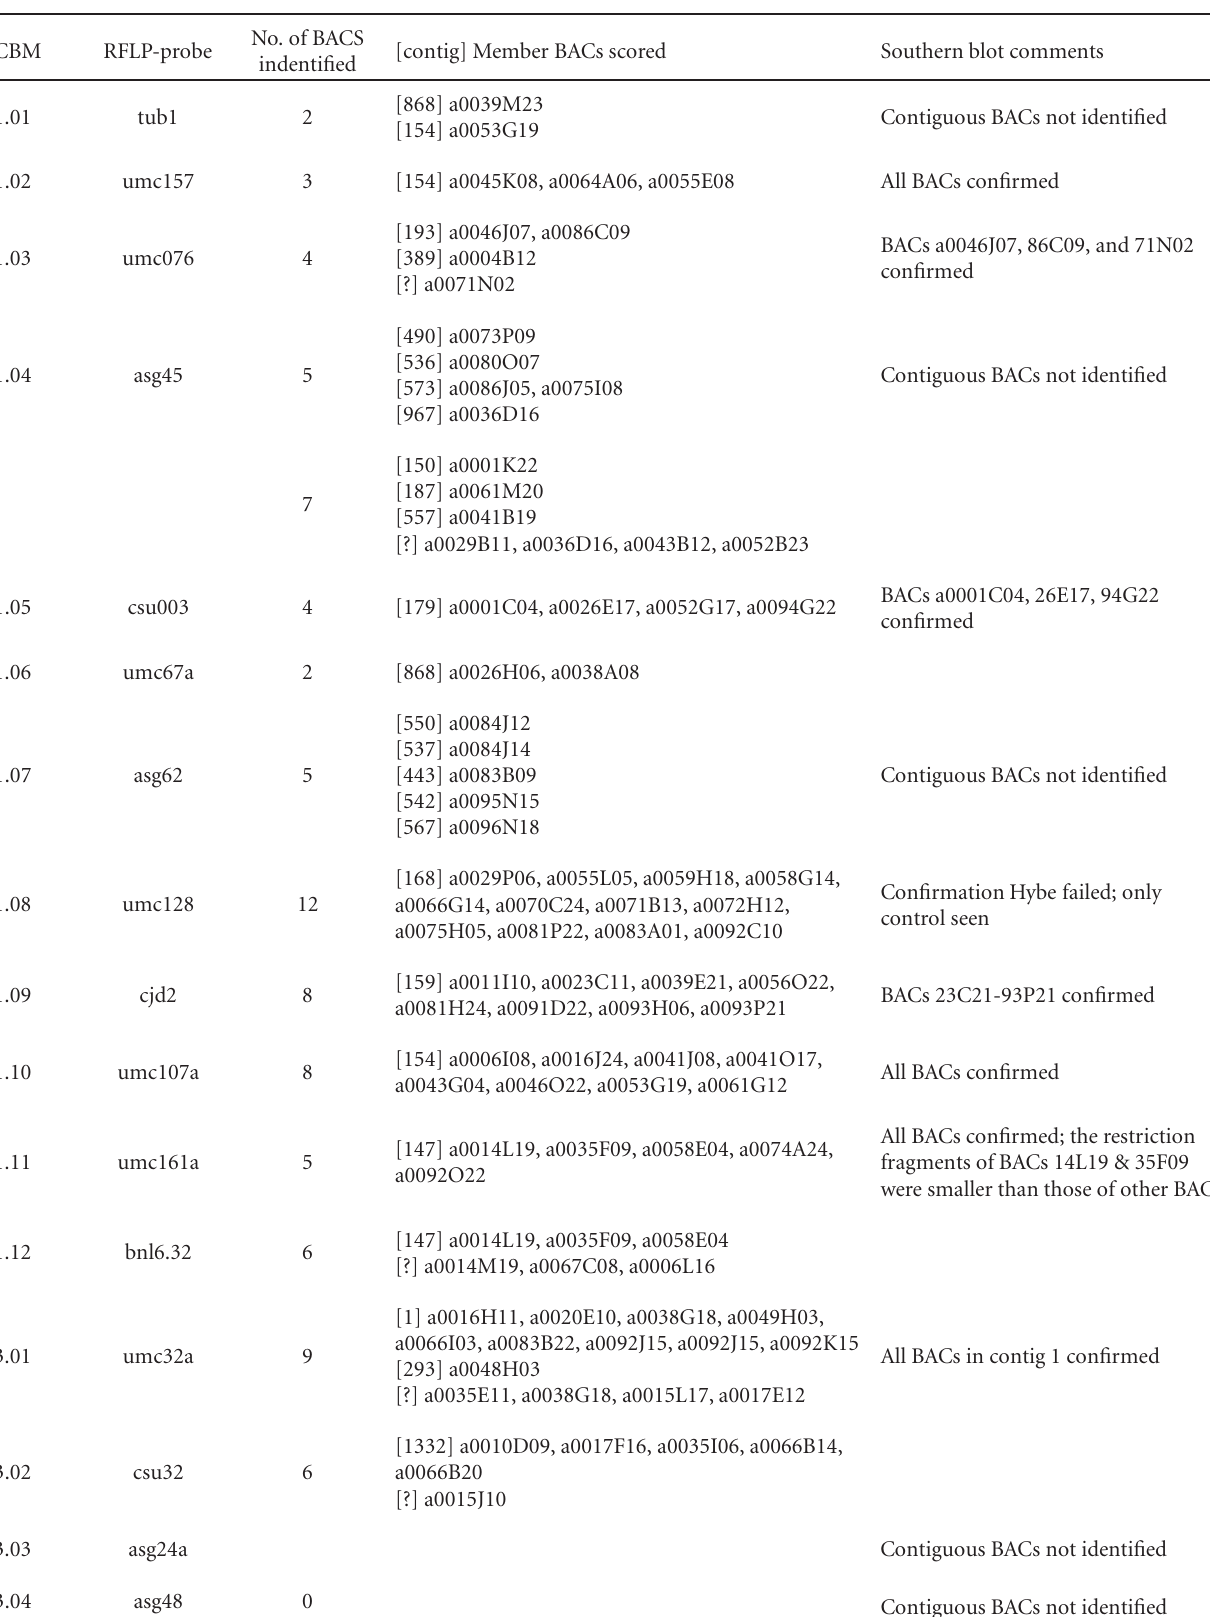
Table 3: Maize CBM-RFLP identified sorghum